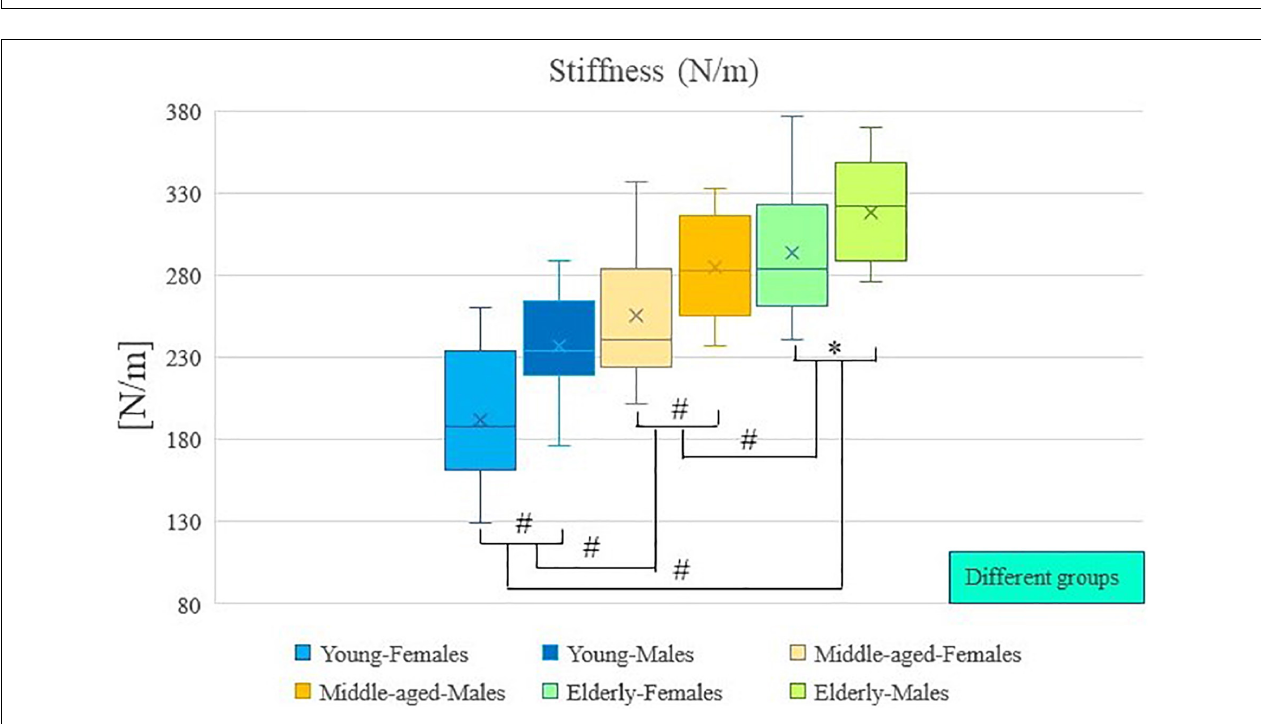
FIGURE 3 | Age and sex differences in stiffness. # Indicates P value < 0.01; ∗ Indicates P value < 0.05.